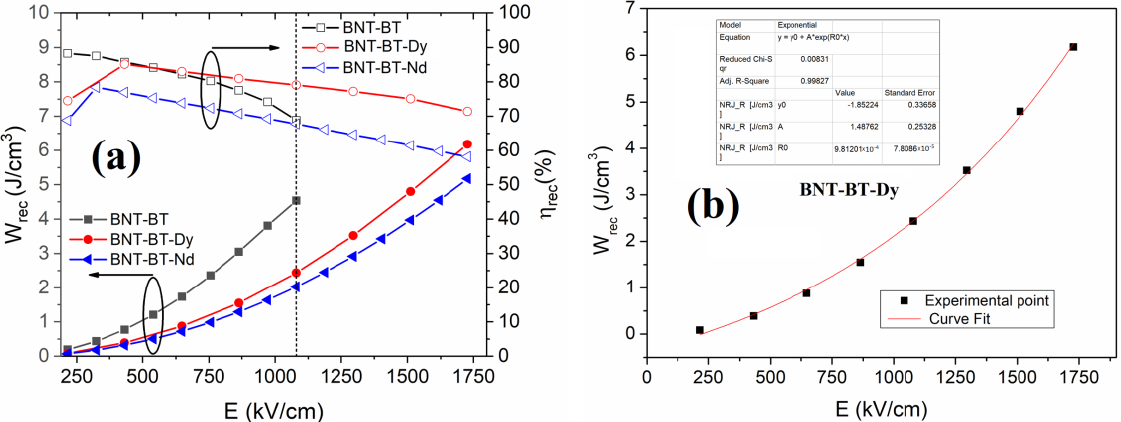
Figure 8. ( a ) Evolution of the energy storage parameters versus field density, and ( b ) Exponential fit of the experimental data for BNT-BT-Dy thin films.